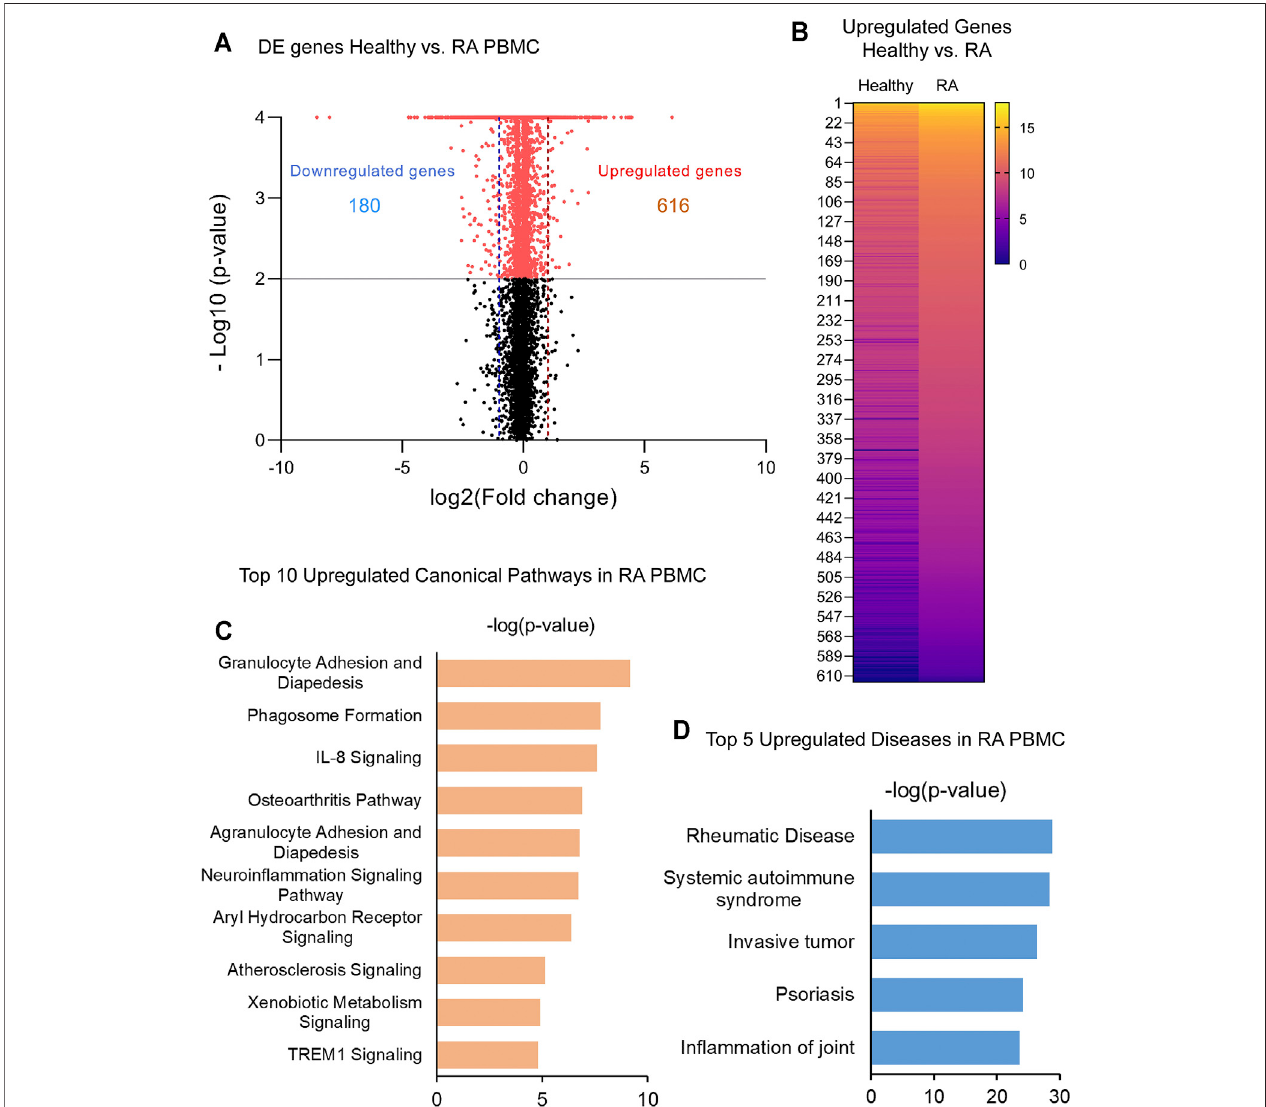
FIGURE 1 | Identi fi cation of upregulated genes and canonical pathways in DMARDs-naïve RA patients. (A) Volcano plot shows differentially expressed genes betweenunstimulatedPBMCfromhealthysubjectsvs.DMARDs-naïveRApatients(RA).Downregulatedgenesareshownonthelefthand(dotedbluelinerepresents2- fold change) and upregulated genes are shown on the right hand (doted red line represents 2-fold change) of the volcano plot. Grey line represents cut-off of p-value (cid:2) 0.05. (B) Upregulated genesfrom healthy subjectsvs. RAwere included intheheatmap (averaged expression patterns ofbiologicalreplicates areshown). (C) Top 10 canonical pathways and (D) top 5 of IPA-predicted disease associations were identi fi ed from upregulated genes between healthy subjects and DMARDs-naïve RA PBMC.